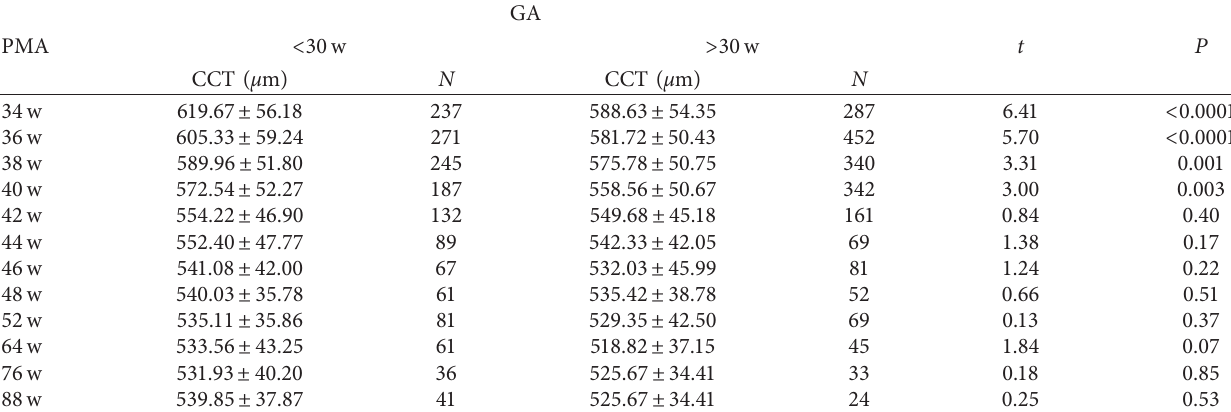
Table 5: Mean CCT of different GAs at each PMA.